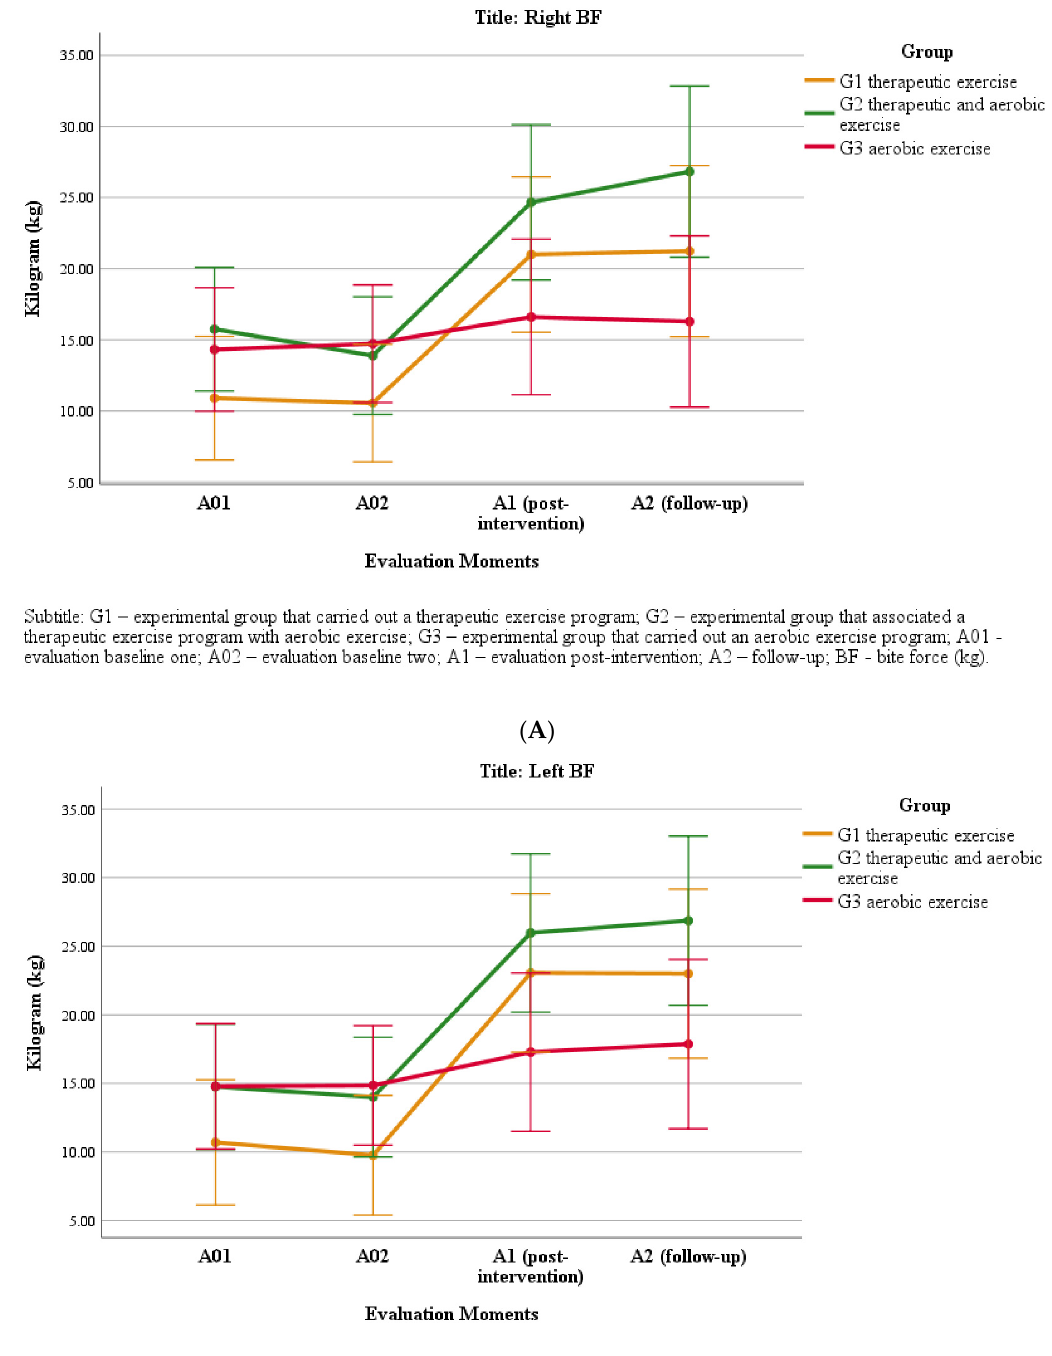
Figure 3. ( A ) Changes in right BF at the different time points. ( B ) Changes in left BF at the different time points.